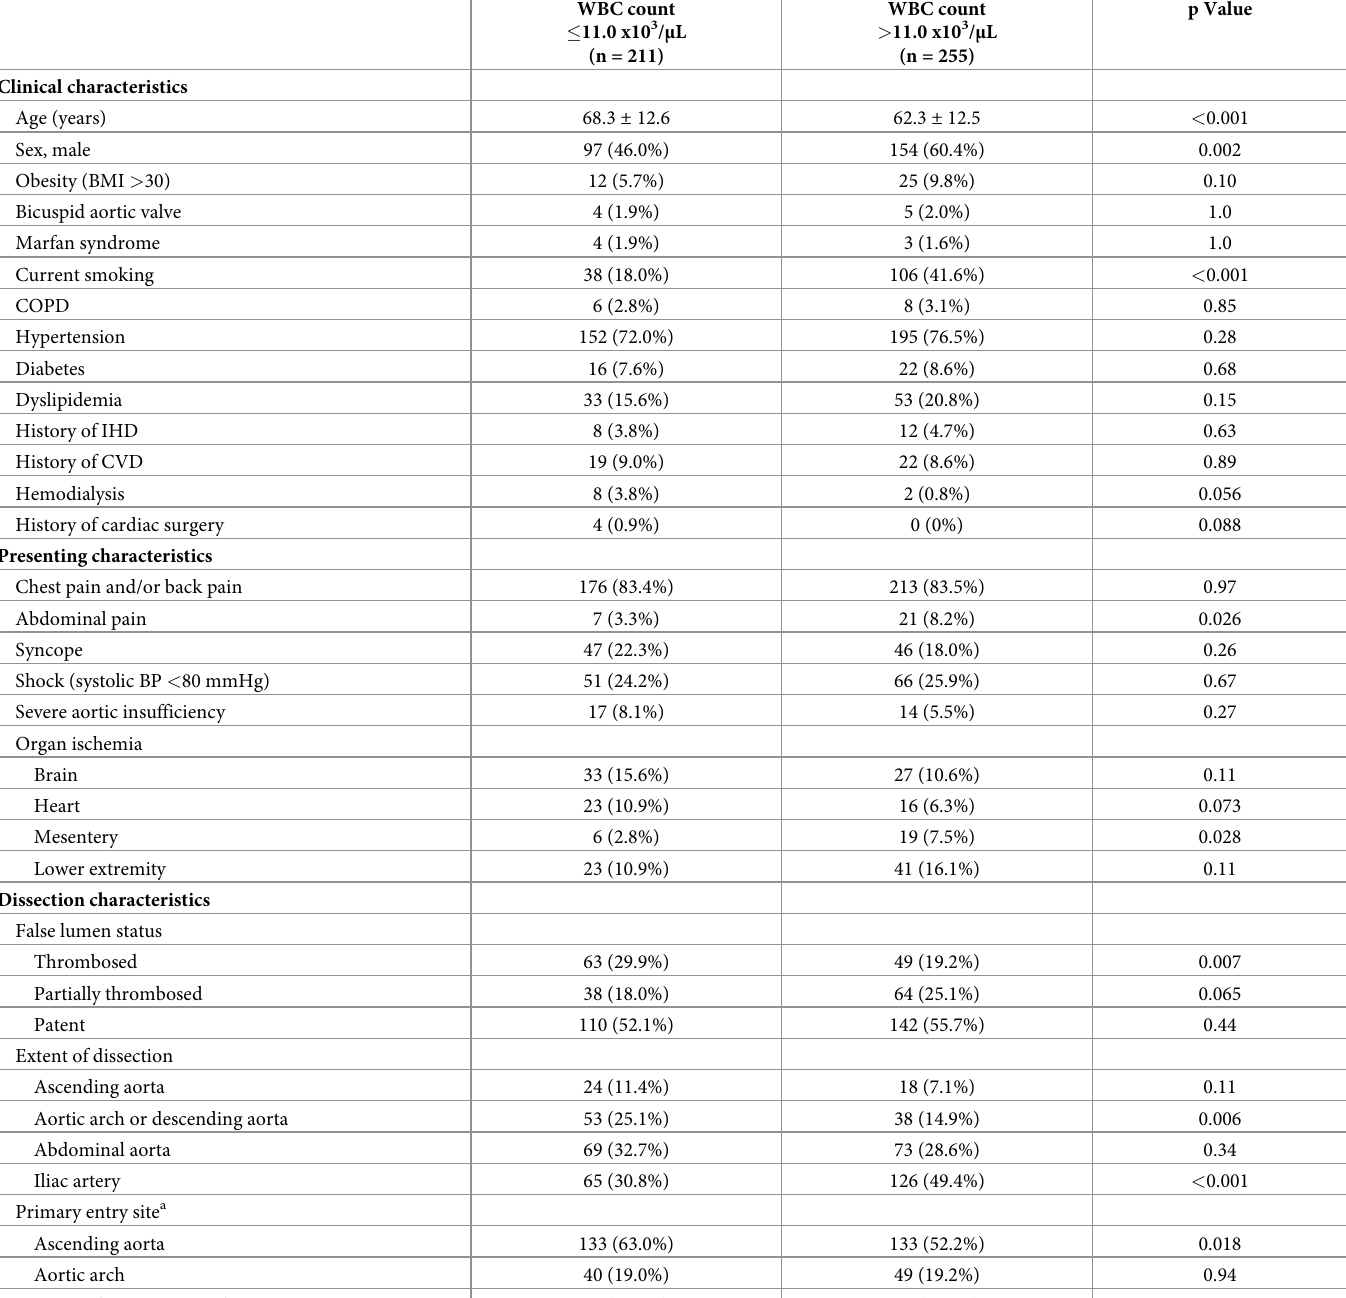
Table 1. Patients’ clinical characteristics, presenting characteristics, and dissection characteristics, per normal and elevated white blood cell counts ( � 11.0 x10 3 / μ L vs. > 11.0 x10 3 / μ